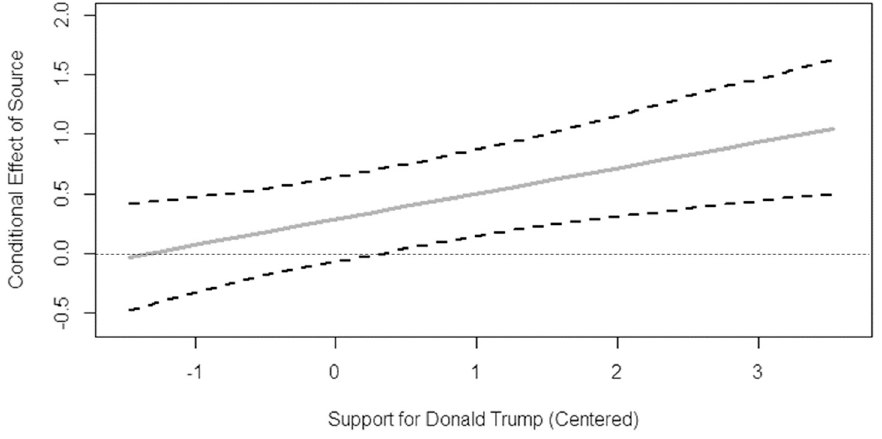
Figure 2. Effect of source on agreement ratings by the degree of Trump support with 95% confidence intervals.